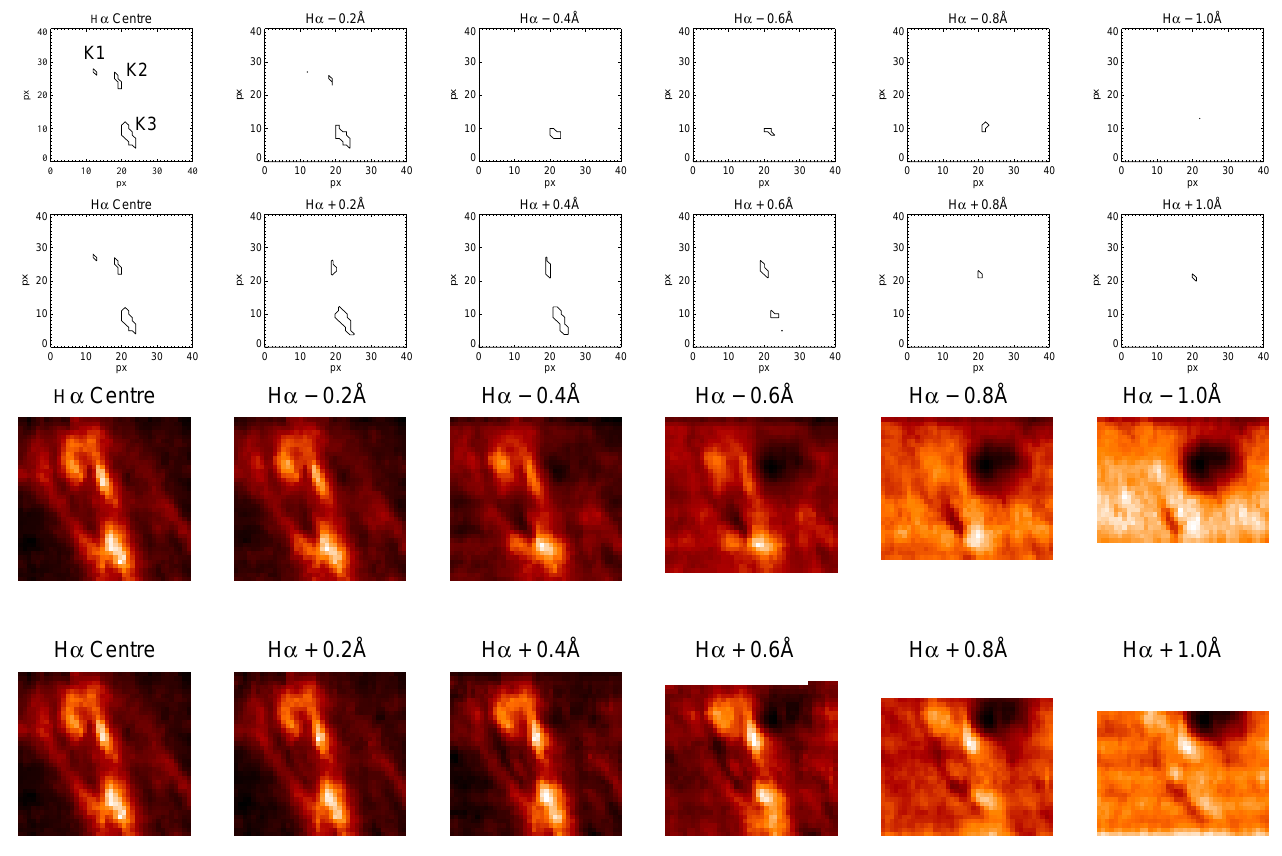
The observational data and data reduction are described in Sect. 2 while the results are presented in Sect. 3 and